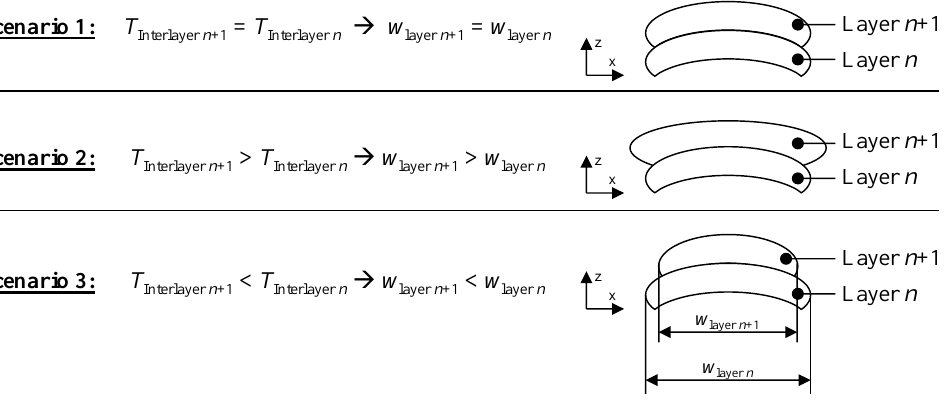
Figure 7. Description of the three scenarios of the temperature deviation affecting the layer widths.